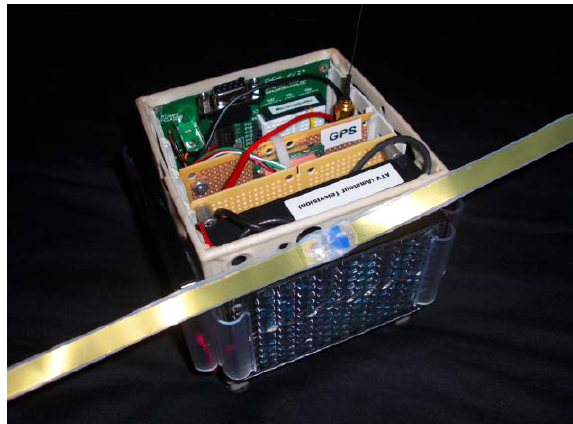
Figure 8. CubeSat built by 8 th grader Bryan Fewell